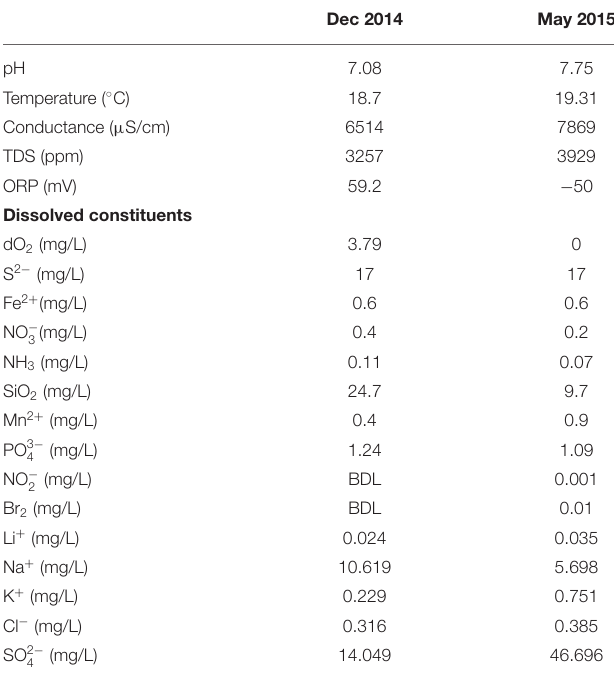
TABLE 1 | Chemical composition of fluid from DUSEL 3A at the 4,850 ft (1,478 mbsl) level, Sanford Underground Research Facility (SD, USA), after commissioning and decommissioning of in situ electrochemical colonization (ISEC)